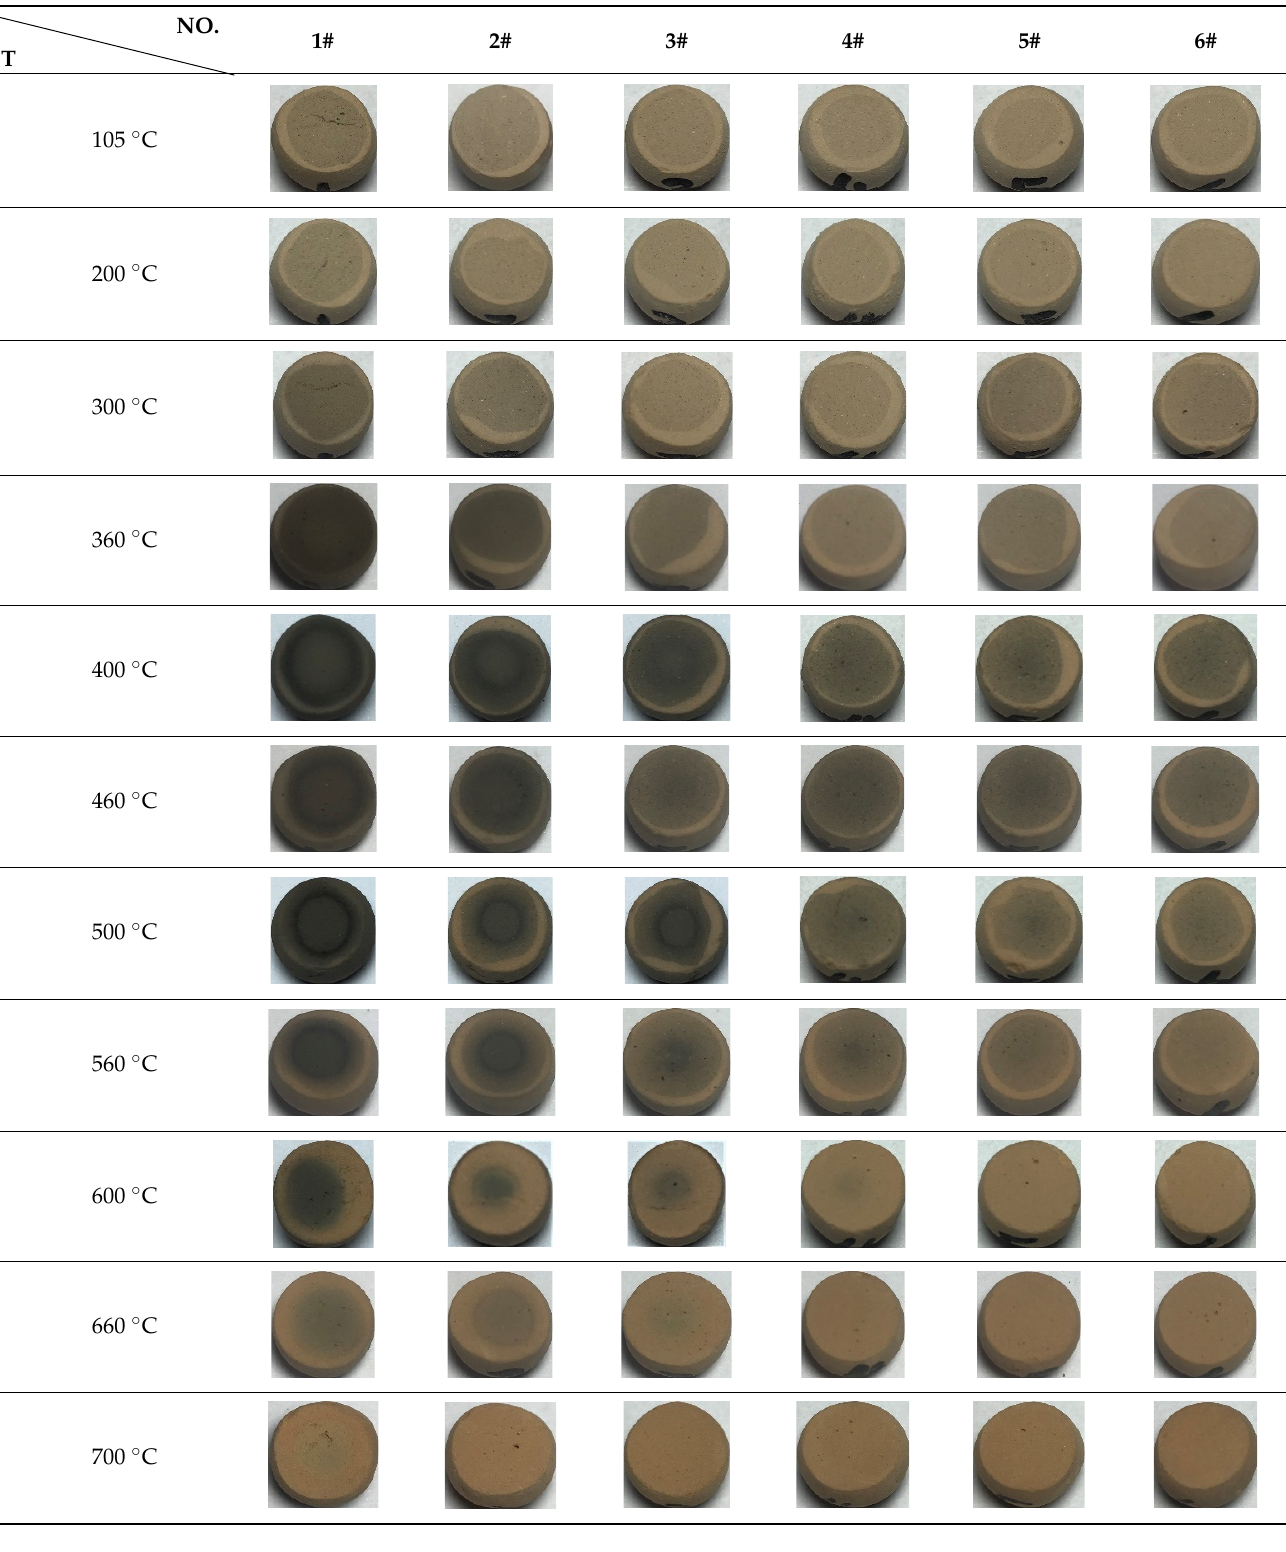
Table 5. Internal structural changes in SS-C composite particles. NO.